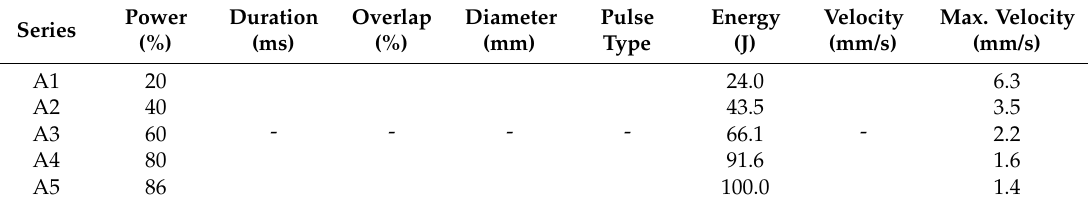
Table A1. Experimental plan for the effects of laser beam power on weld